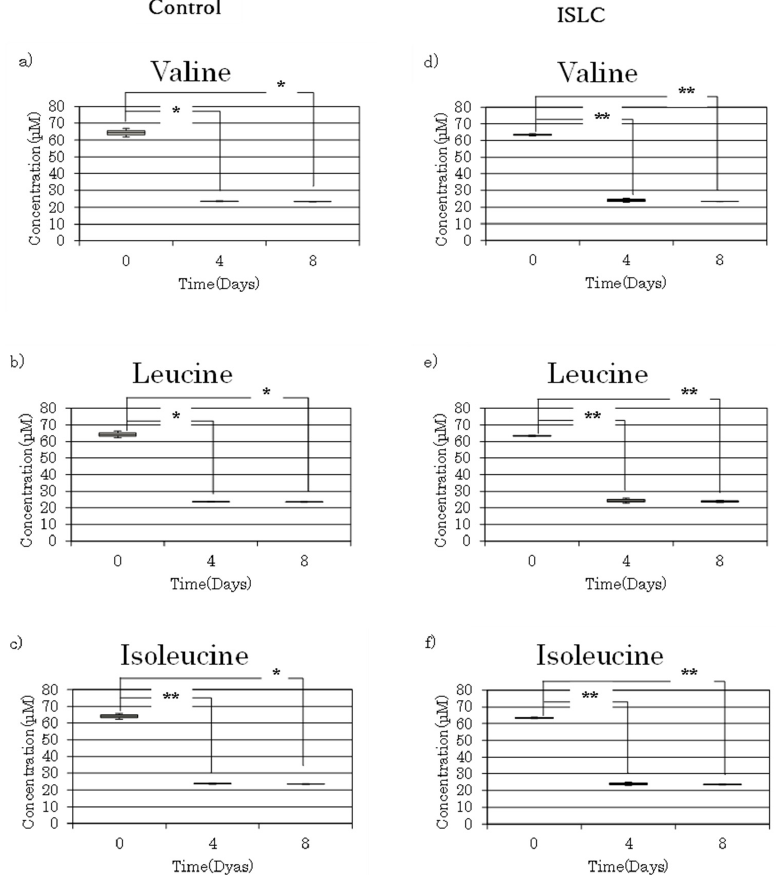
Figure 3. Comparison of BCAAs in medium for 4 and 8 days after di ff erentiation. We measured concentrations of BCAA in medium of 3 di ff erent time points (day 0, 4, and 8 of adipogenesis) by HPLC. Alteration pa tt erns of BCAA are shown for control cells ( a – c ) and cells treated with ISLCs ( d – f ). p values were calculated according to the Student’s t -test: * p < 0.05, ** p < 0.01.